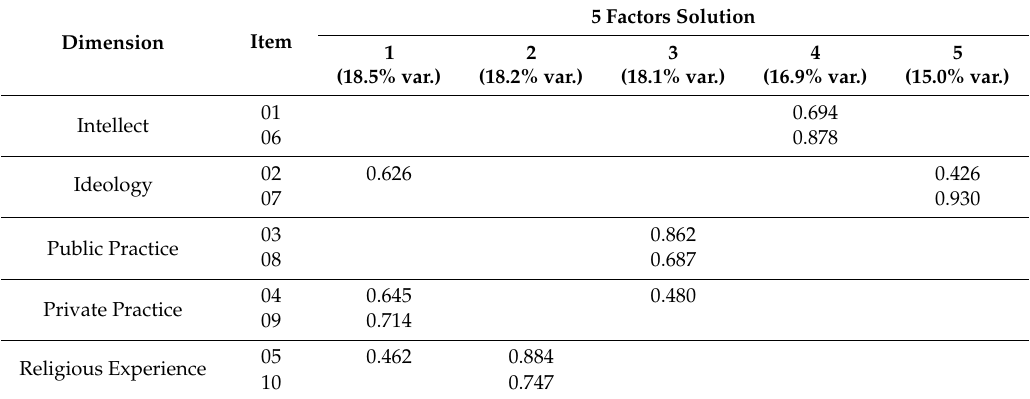
Table 6. Rotated component matrix of the five factors